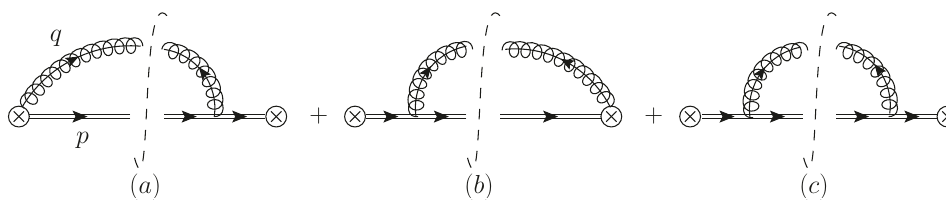
Figure 4 . Real-radiation diagrams contributing to the jet function at O ( (cid:11) s